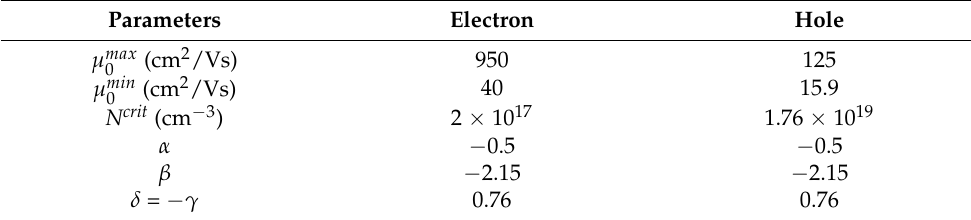
Table 2. Carrier mobility parameters used for the Caughey–Thomas model. Parameters